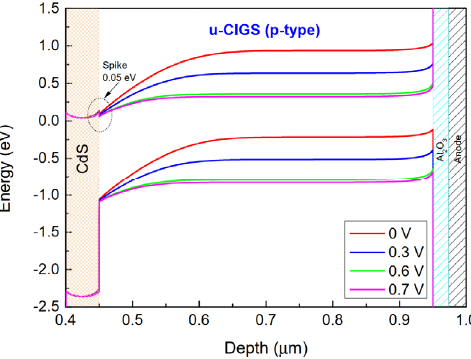
Figure 3. Band diagram of an ultrathin CIGS solar cell under different bias conditions (under illumination).